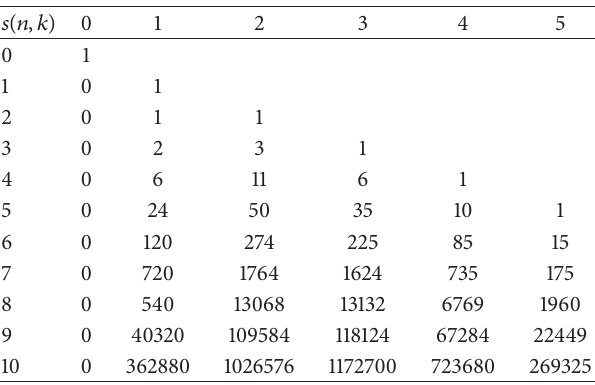
Table 3: Values of |𝑠(𝑛,𝑘)| for 0 ≤ 𝑛 ≤ 10